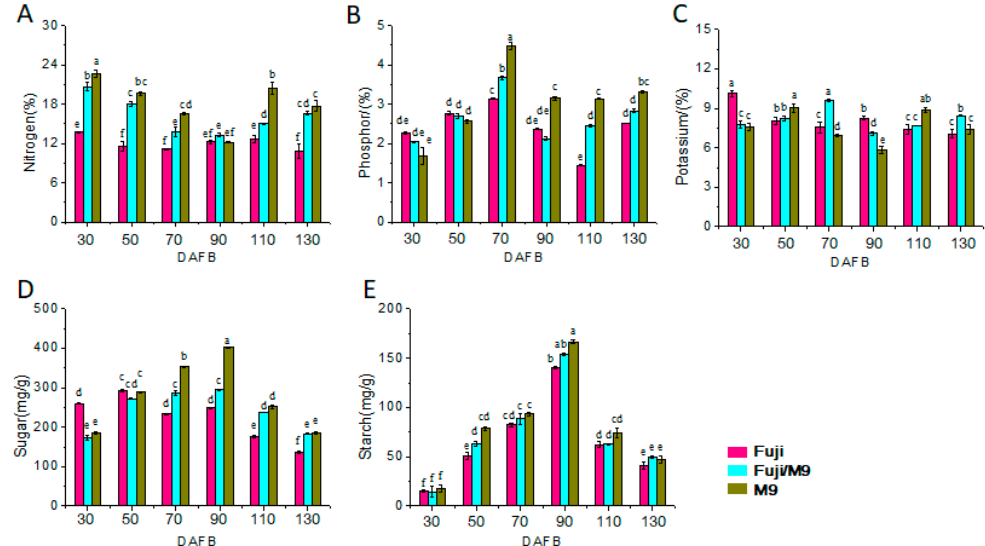
Figure 3. Total nitrogen (N), phosphorus (P), potassium (K), soluble sugar, and starch content of terminal buds in different apple trees: ( A ) total N content, ( B ) total P content, ( C ) total K content, ( D ) total soluble sugar content, and ( E ) starch content. Values followed by different lowercase letters mean significant at p < 0.05